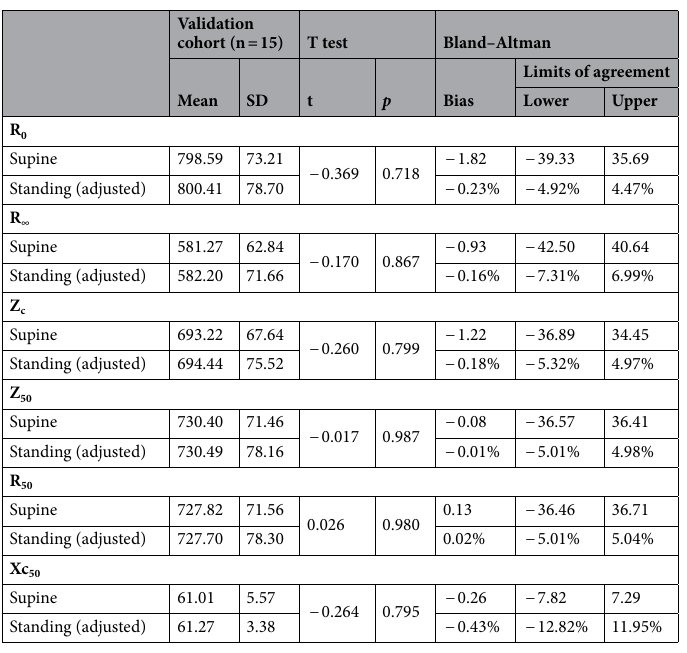
Table 5. Bioimpedance body position adjustment equations applied to standing (≥ 4 min) measurements in validation sub-group (n = 15). R 0 resistance at 0 kHz, R ∞ resistance at infinite kHz, Z c impedance at